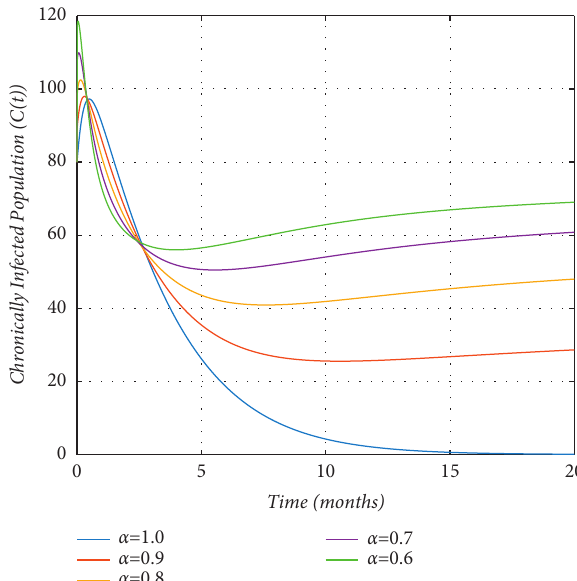
Figure 3: The graph demonstrates the dynamics of the chronically infected population against different values of the fractional-order parameter ( α ), and the initial sizes of the population are ( 100 , 90 , 80 , 70 , 60 ) .